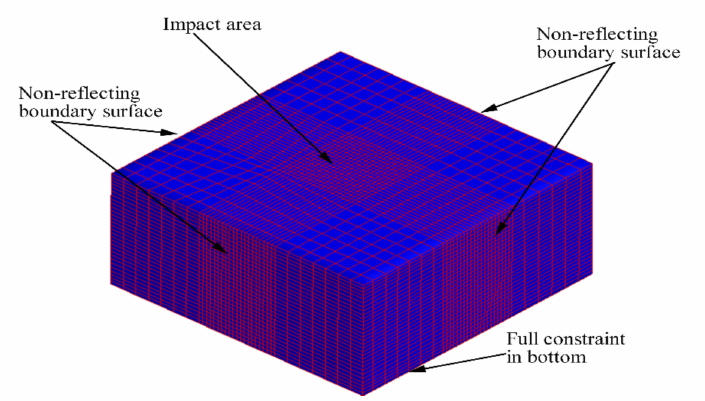
Figure 2. Boundary conditions in FEM model.